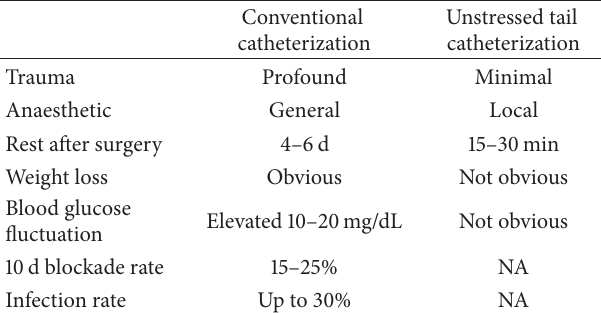
Table 1: Comparison of conventional catheterization and unstressed tail vein-artery catheterization in normal SD